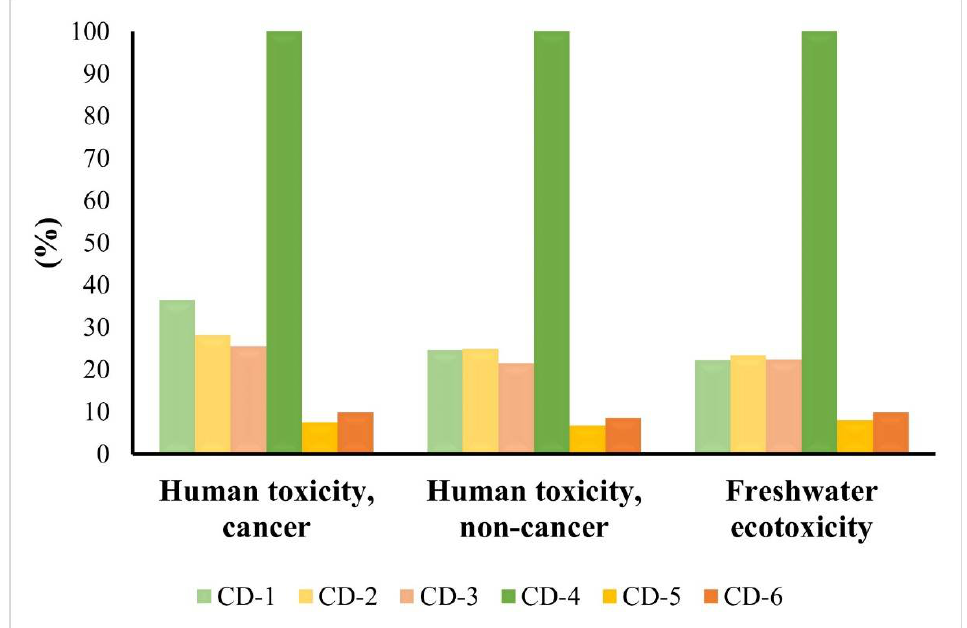
Figure 15. Relative environmental impacts of all syntheses for landfill disposal scenario, applying USEtox method. Green scale refers to hydrothermal treatments; Yellow scale refers to microwave- assisted treatments; Orange scale refers to calcination treatments.